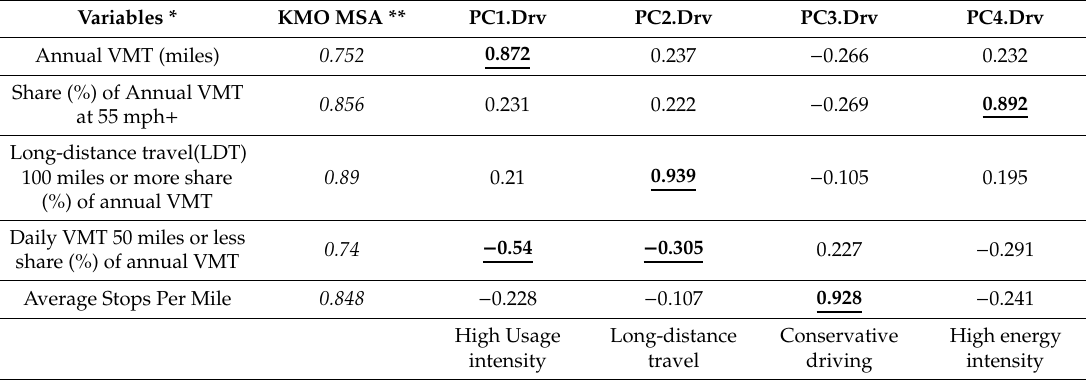
Table 6. PCA of Driving Behavior: Varimax Rotated Factor Loadings and Influential Driving Traits